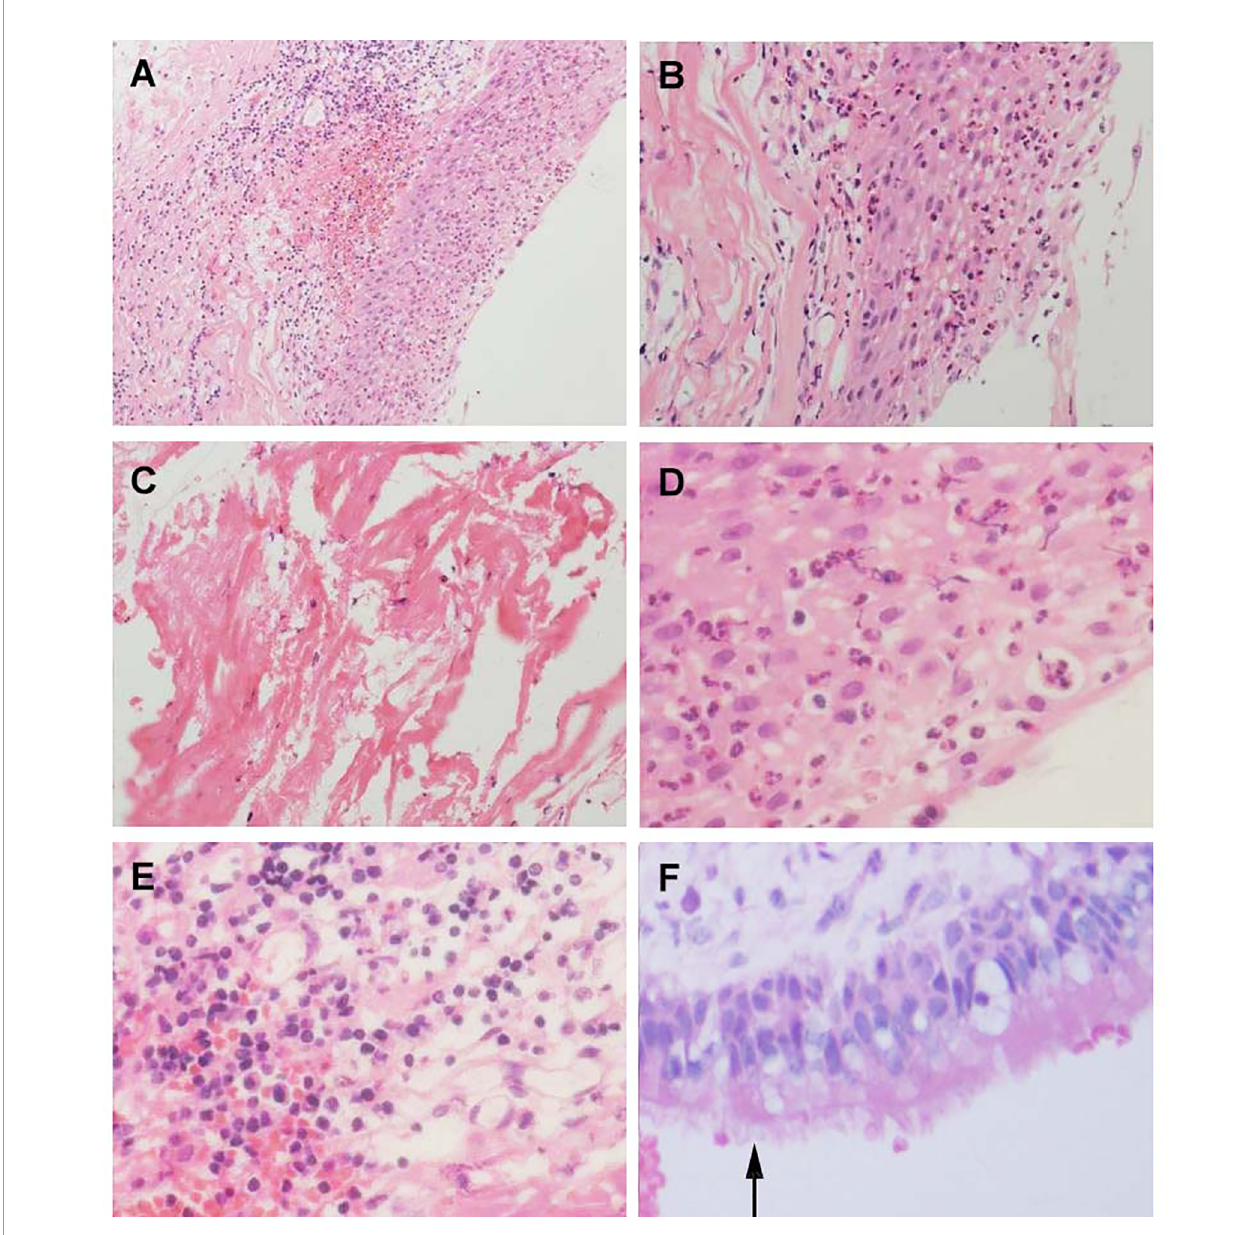
FIGURE 5 | Histological feature of Aneurysm with Rathke ’ s cleft cyst, H&E stained section. (A) Shows the histological features of simple partial covered squamous epithelium with fi brous connective tissue presents acute and chronic in fl ammation (×150). (B) Squamous epithelial mucosa (×300). (C) The keratin in the cyst wall. (D) cystic wall lined by a squamous epithelium (×400). (E) Groups of in fl ammation cells (400×). (F) cuboidal ciliated epithelium cells(arrows)